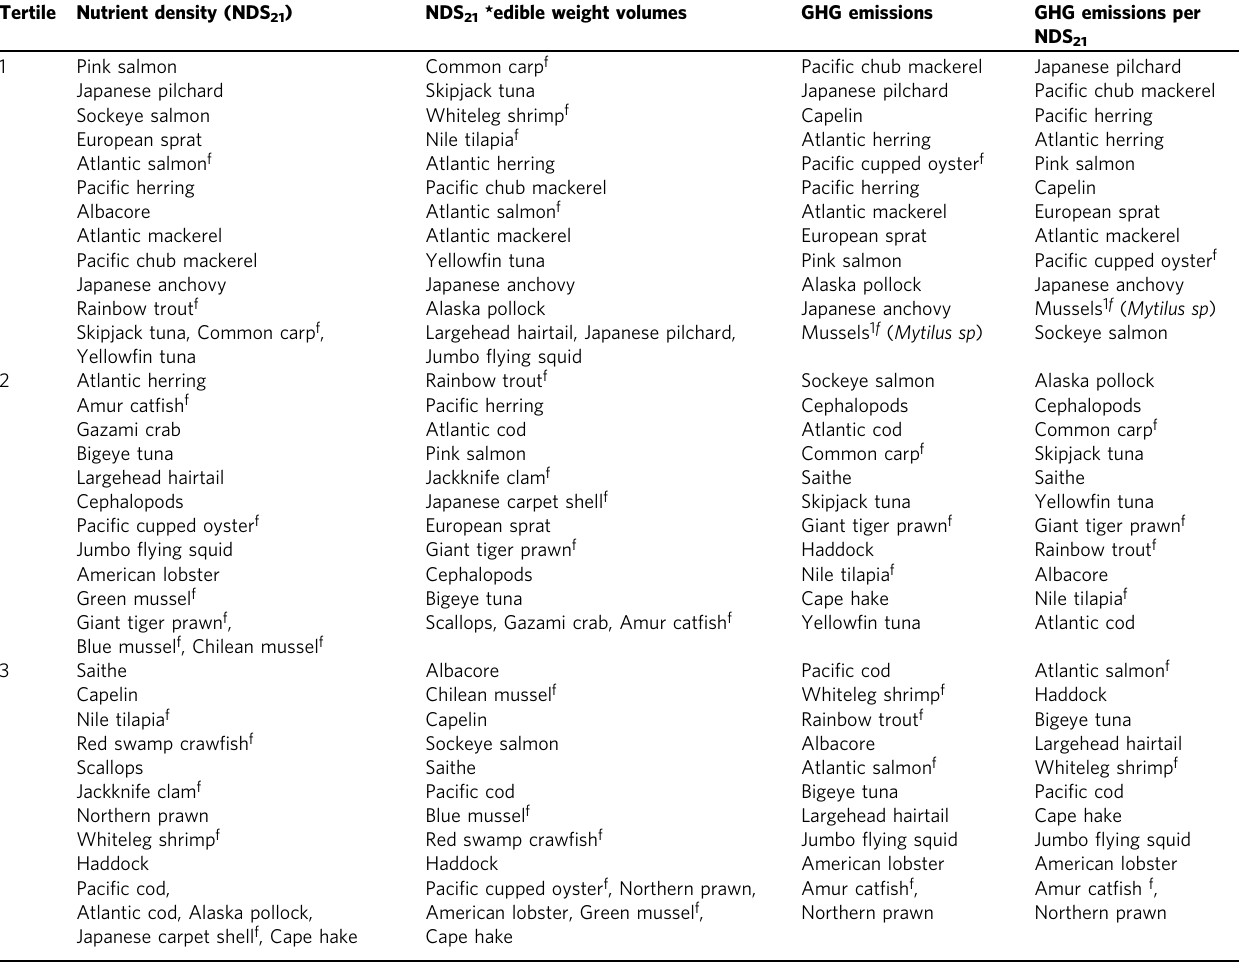
Table 1 Ranking of seafood products from highest (1) to lowest (3) tertile for nutrient density and globally weighted nutrition, and from the lowest (1) to the highest (3) tertile for GHG emissions per kg edible seafood and relative to nutrient density. Lowest ranking species in each tertile are grouped to minimize